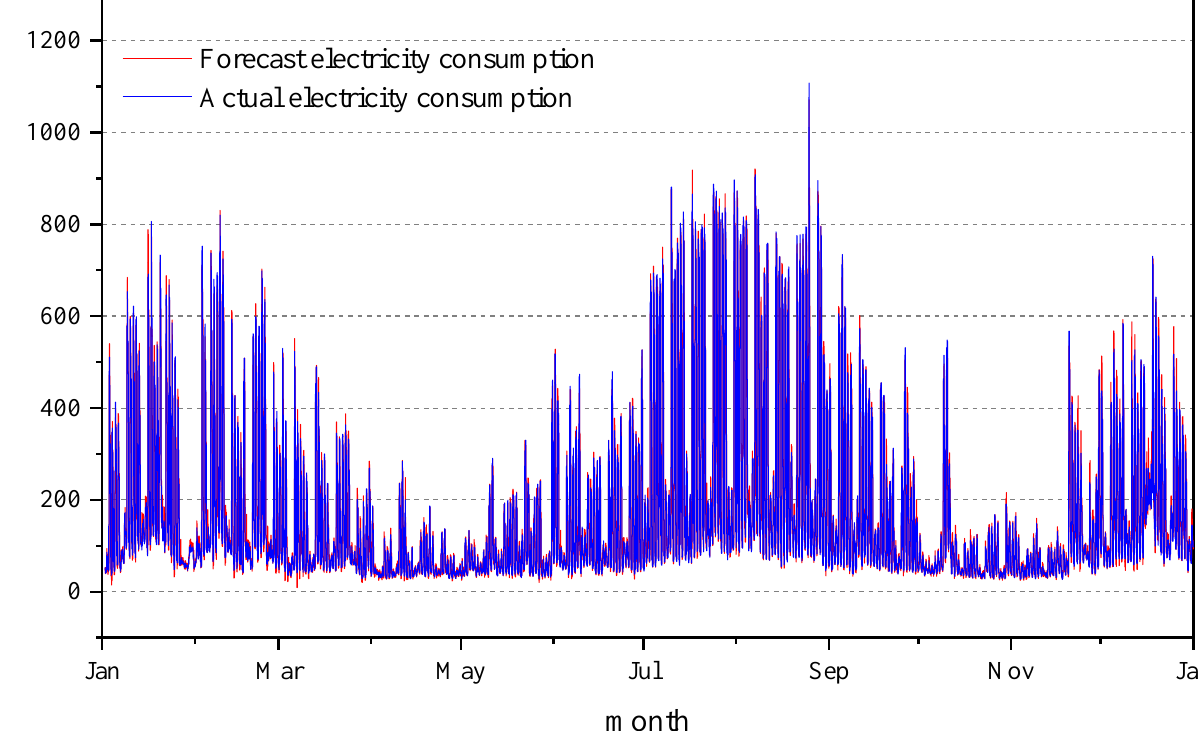
Figure 8. Air-conditioning electricity forecast in 2017.